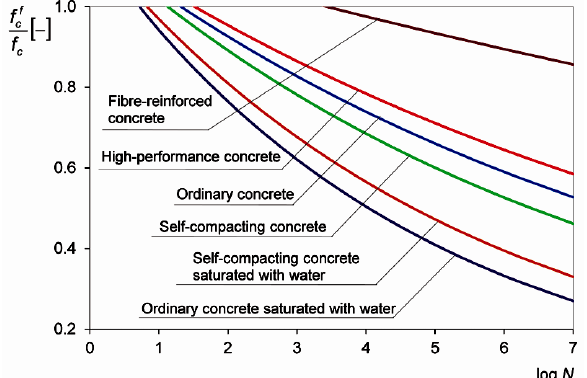
Fig. 13. Fatigue strength versus load cycles, calculated for ordi- nary concrete, high-performance concrete, self-compacting concrete and fibre-reinforced concrete assuming ρ f = 0 and f = 1